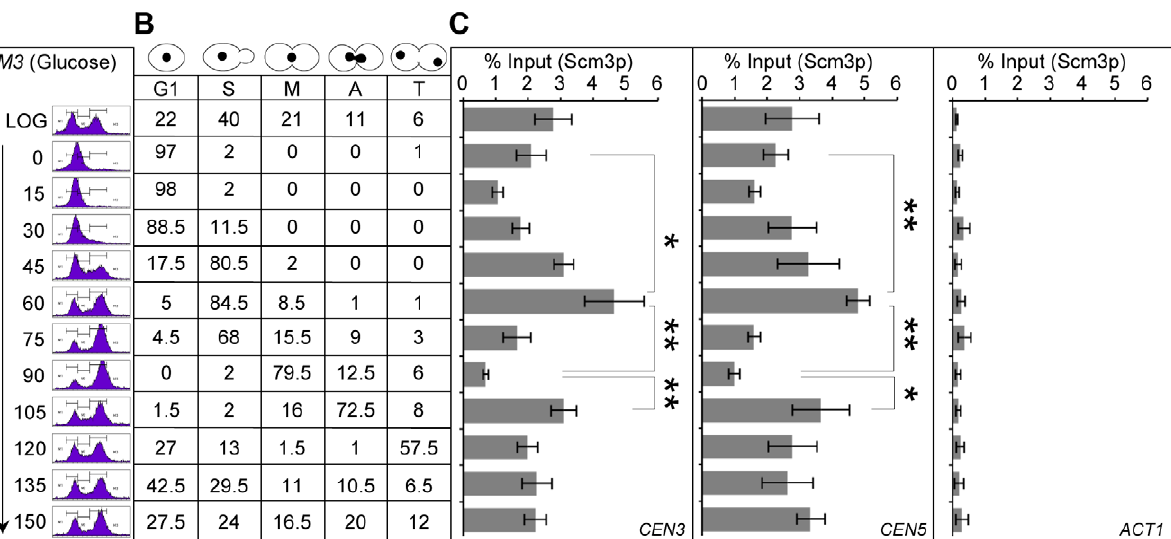
Figure 2. Centromeric association of Scm3p is cell cycle regulated. A wild-type strain (RC154) with FLAG tagged Scm3p expressed from its own endogenous promoter was grown in YPD, synchronized in G1 with a -factor, washed, and released into pheromone-free YPD medium. Samples were taken at time points (min) after release from G1. (A) DNA content was determined by FACS. (B) Cell cycle stages were determined based on cell morphology and nuclear position by microscopic examination of 200 cells for each time point as described in Materials and Methods. (C) Enrichment levels of Scm3p at CEN3 , CEN5 and ACT1 (background control). ChIP experiments were done using a -FLAG (Scm3p), and a -GST (mock) antibodies. The enrichment of Scm3p at CEN3 , CEN5 , and ACT1 was determined by qPCR and is shown as % input. Average from at least three